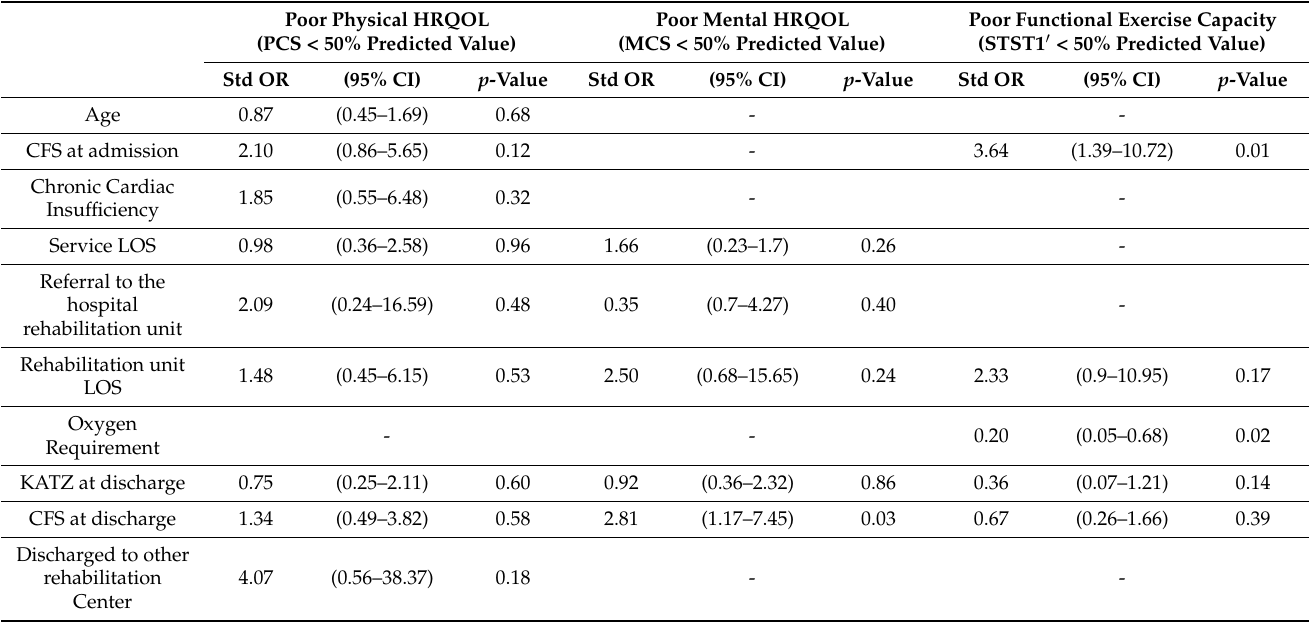
Table 4. Multiple regression models for health-related quality of life and functional exercise capacity at the time of the remote